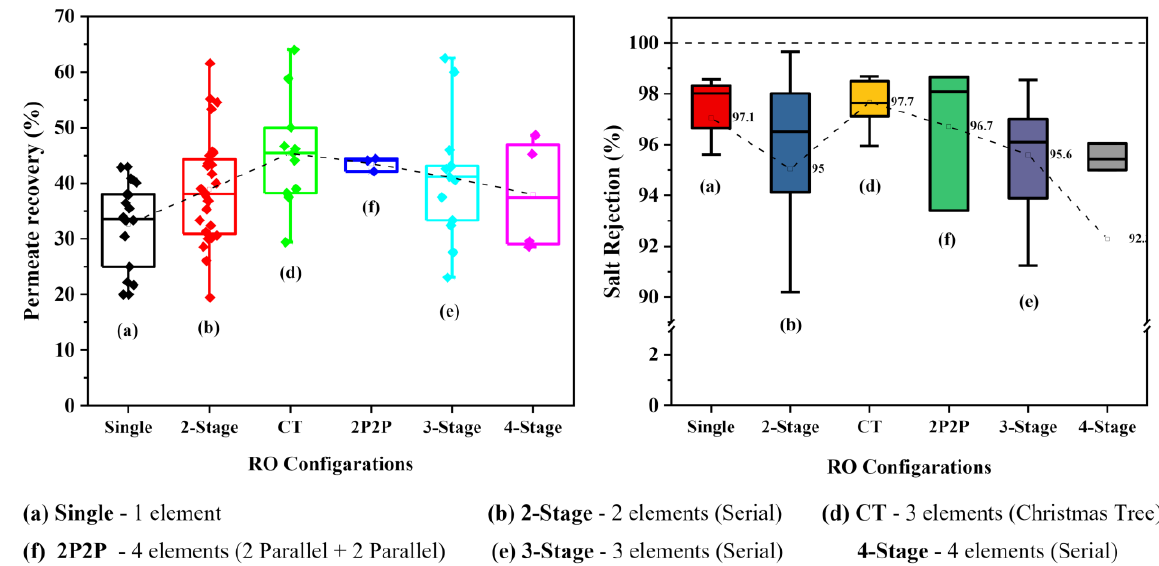
Figure 6. Variation of permeate recovery ( left ) and the salt rejection rates ( right ) with the common RO configurations in NCP. Configurations indicated by ( a , b ) and ( d – f ) are illustrated in Figure S2.